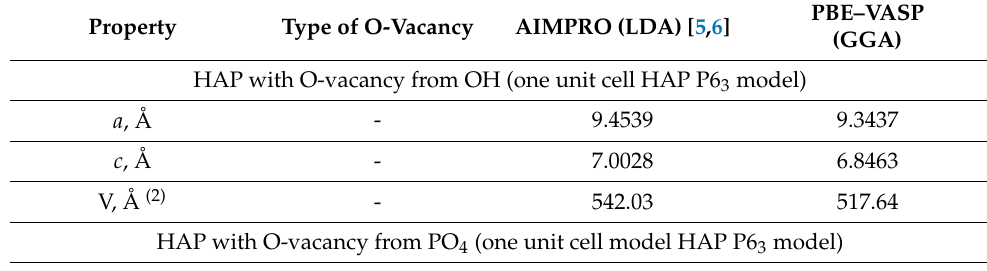
Table 3. The calculated HAP lattice parameters with various type of the